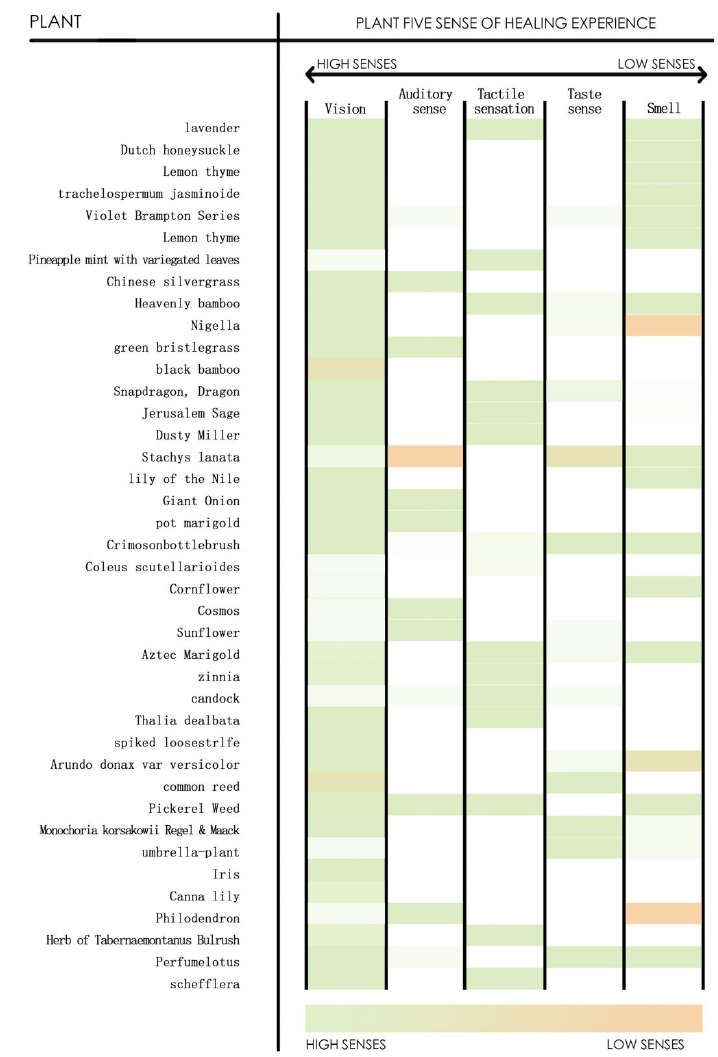
Figure 9. Statistical Diagram of Plant Five Sensory Modes .